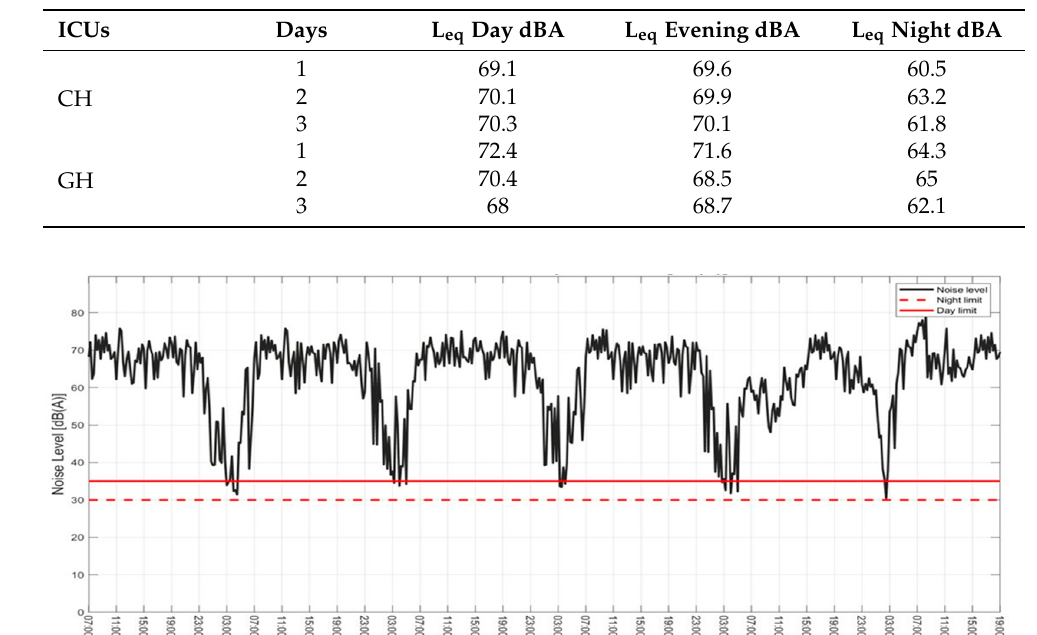
Figure 7. The equivalent noise level (L eq ) per hour measured and the day-evening-night noise level (L den ) in the GH ICU.